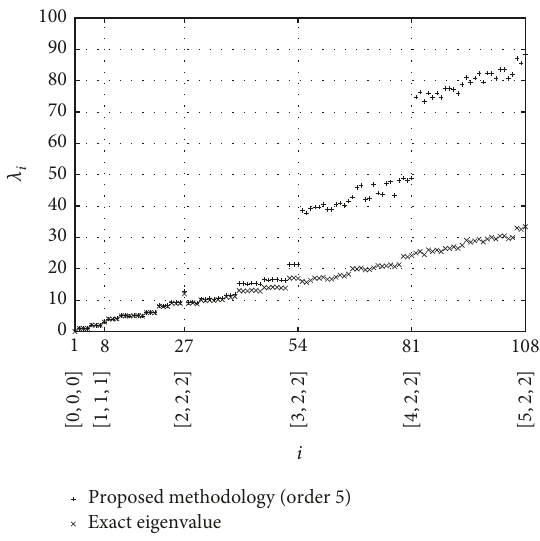
Figure 11: Cuboid eigenvalues (7th order, 𝑁 = 3 ).